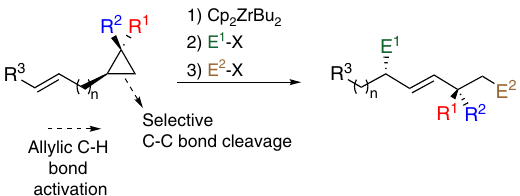
Figure 1 | Comparison between the different strategies for the functionalization of organic skeletons. ( a ) Classical approach for the selective interconversion of a functional group. ( b ) Chemoselective interaction between a metal and a specific moiety allowing the creation of functionalized organometallic species, leading to a variety of electrophilic substitution reactions. ( c ) Remote functionalization through metal migration strategy enabling a transformation away from a functional group at a distant position (FG 2 ); located further away from (FG 1 ). Despite many inherent advantages, this approach does not allow the presence of the highly regarded quaternary carbon stereocentre. ( d ) Proposed sequence where a strategically stereodefined polysubstituted cyclopropane vault is used assuming that the ring-strain release may drive the chain-walking process towards the formation of acyclic products and allowing the introduction of an internal substitution on the carbon skeleton. ( e ) Illustration of this sequence was reported for the addition of stoichiometric amount of low-valent zirconocene derivatives to o -alkenyl cyclopropanes generating a cascade of events composed by successive allylic C–H bond activations, selective C–C bond cleavage and finally reaction with two different electrophiles (E 1 X and E 2